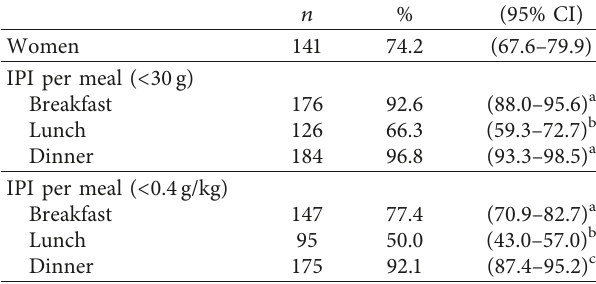
Table 3: Summary of the significance of independent variables introduced in the multinomial logistic regression for estimating functionality. 190). (cid:31) (cid:31)